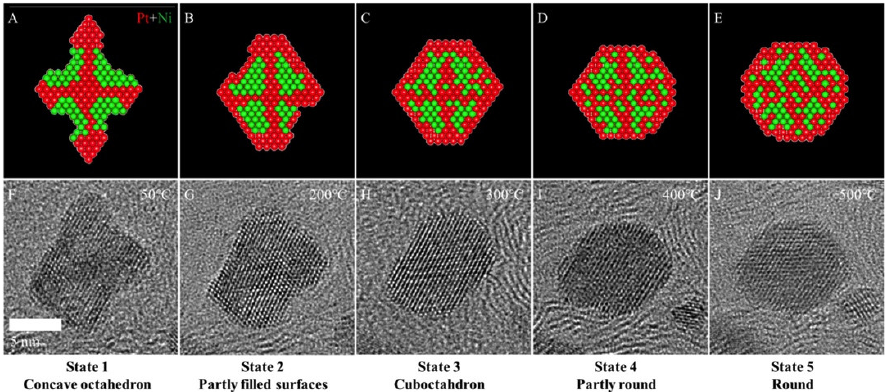
Figure 8. Illustrations ( a – e ) of proposed Pt (red) and Ni (green) atomic distributions in NiPt octahedra that undergo transformations during in situ thermal heating at escalating temperature and their corresponding HRTEM images ( f – j ). Reprinted with permission from reference [80]. Copyright 2018 American Chemical Society.